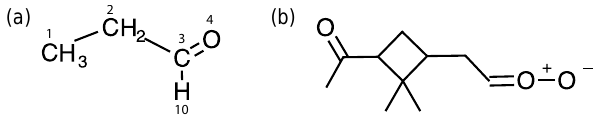
Figure 1. Propionaldehyde ( a , SMILES code CCC = O) and com- pound named APINOOB in MCMv3.2 scheme ( b , SMILES code [O-][O + ] = CCC1CC(C( = O)C)C1(C)C). The carbon and oxygen atoms are enumerated, together with the hydrogen of the aldehyde group in compound (a) .